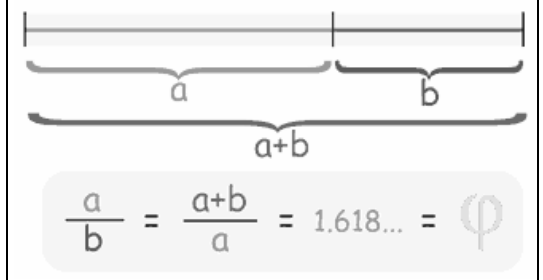
Figure 4. Caluculation of the Golden